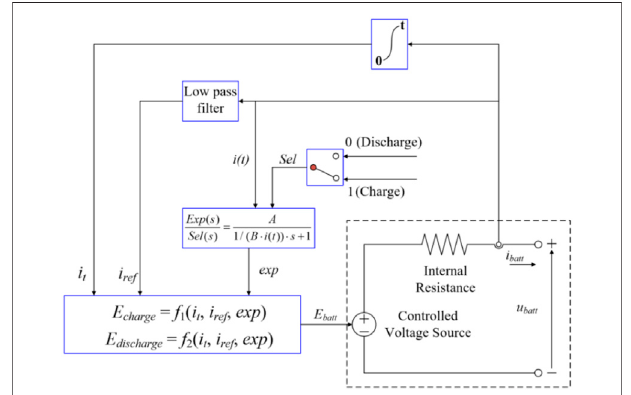
FIGURE 2 | Model of the BESS.